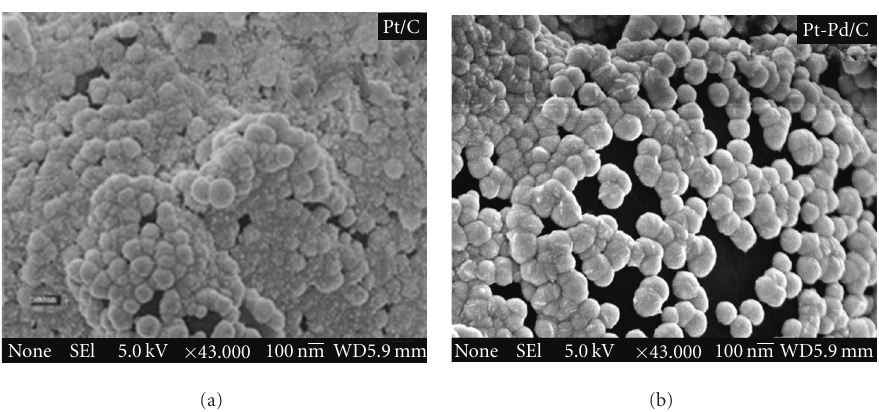
Figure 1: Scanning electron micrographs (SEM) of Pt/C and Pt-Pd/C electrocatalysts.